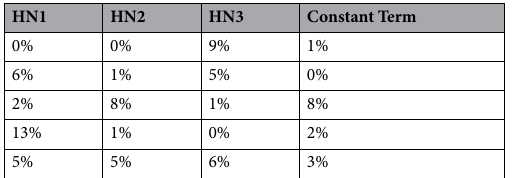
Table 1. Hidden Layer (HN) (Fig. 8b) Error Matrix showing the Absolute Deviation of the Physical Programmed Conductance Values and the Ideal Mapped Neural Network Values per Device.